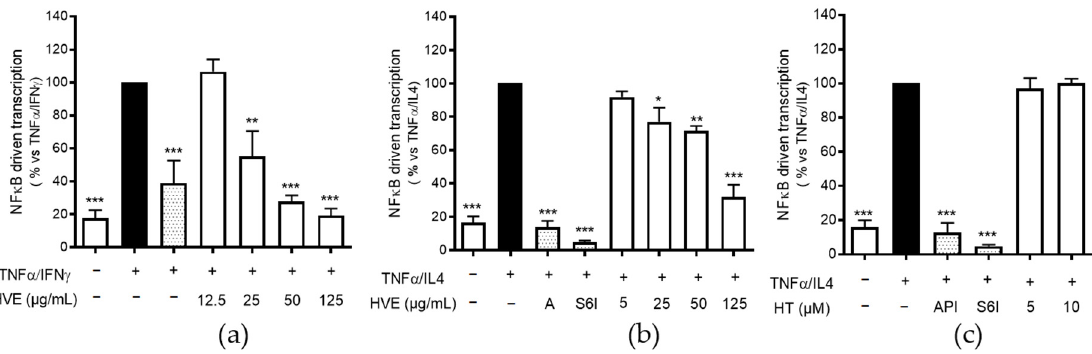
Figure 4. The inhibitory effect of HVE treatment (24 h) on the NF- κ B-driven transcription in HaCaT cells challenged by TNF- α (10 ng/mL)/IFN- γ (10 ng/mL) ( a ) or TNF- α (10 ng/mL)/IL-4 (100 ng/mL) ( b ), measured by plasmid transfection. The involvement of HT (10 µ M corresponding to 4.93 µ g/mL) in the inhibitory effect against TNF- α /IL-4 challenge was excluded ( c ). The data are expressed in percentages, relative to the stimulated control, which is arbitrarily assigned a value of 100%. * p < 0.05, ** p < 0.01, *** p < 0.001 versus stimulus. HVE, Hamamelis virginiana bark extract; reference inhibitors: A, apigenin (20 µ M); S6I, STAT-6 inhibitor (50